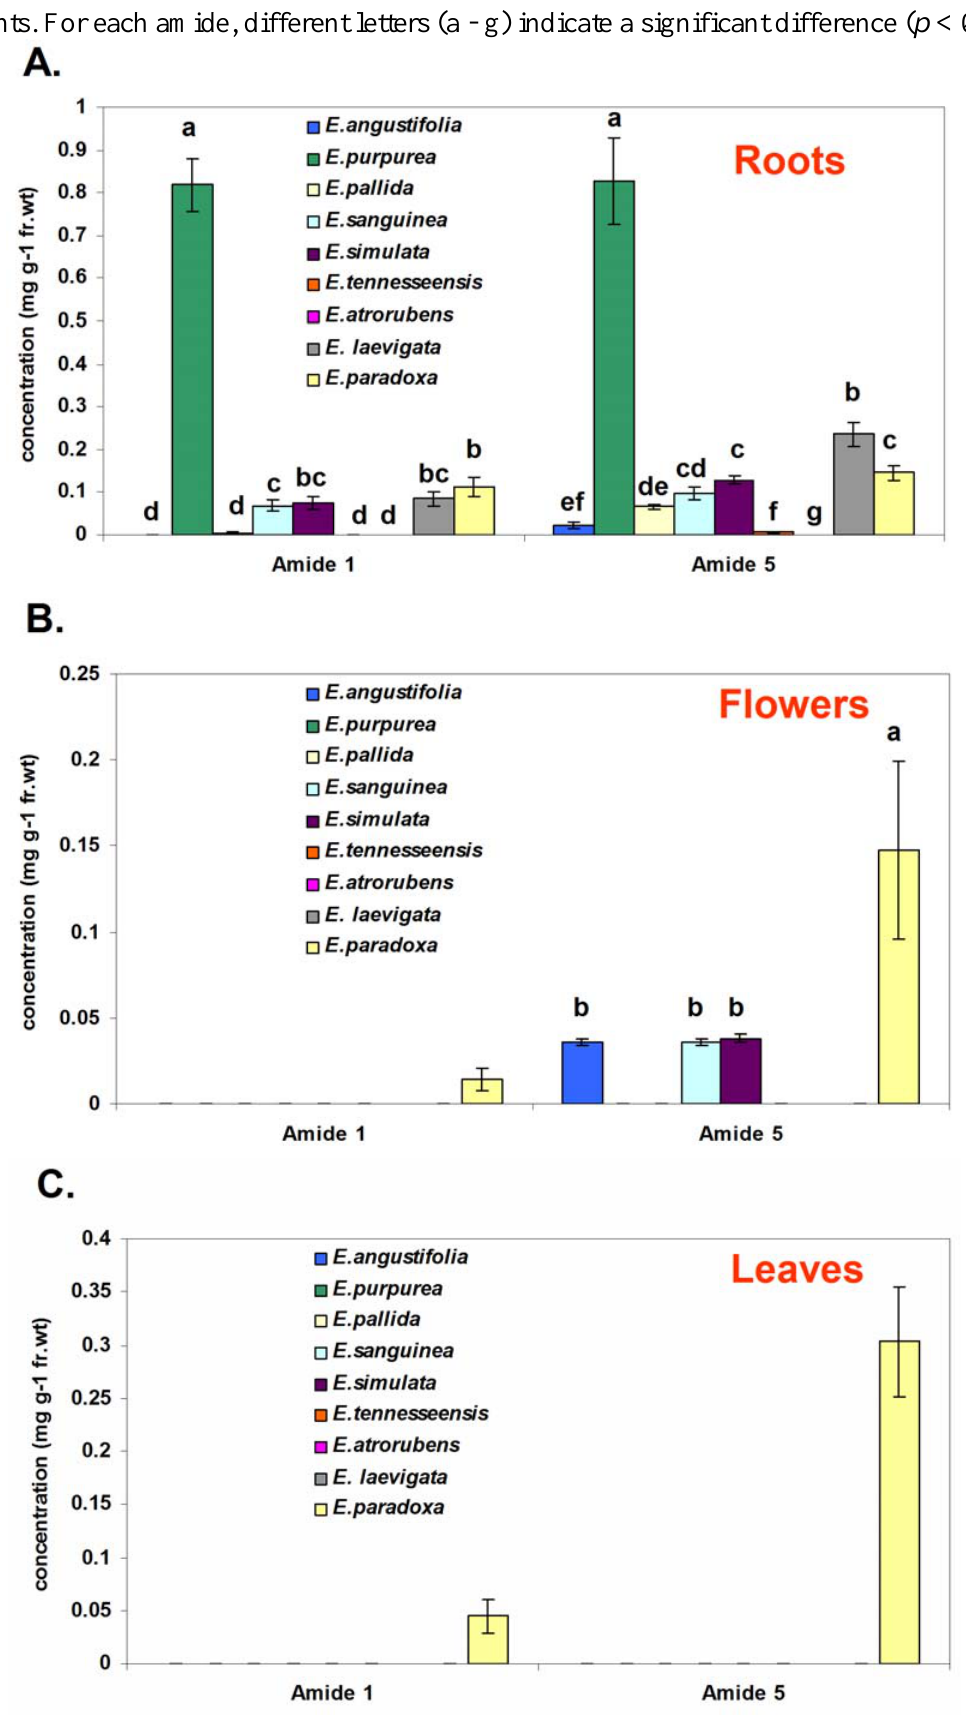
Figure 2. Concentration of amides 1 and 5 in roots (A), flowers (B), and leaves (C) from 6-month- old plants of nine species of Echinacea . Error bars indicate standard deviations of means of triplicate experiments. For each amide, different letters (a - g) indicate a significant difference ( p <